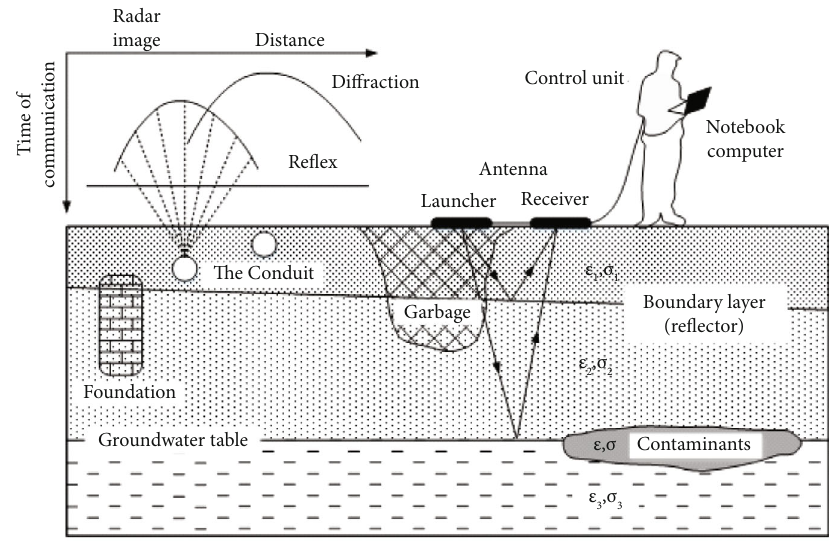
Figure 1: Con fi guration diagram of the ground-penetrating radar antenna.